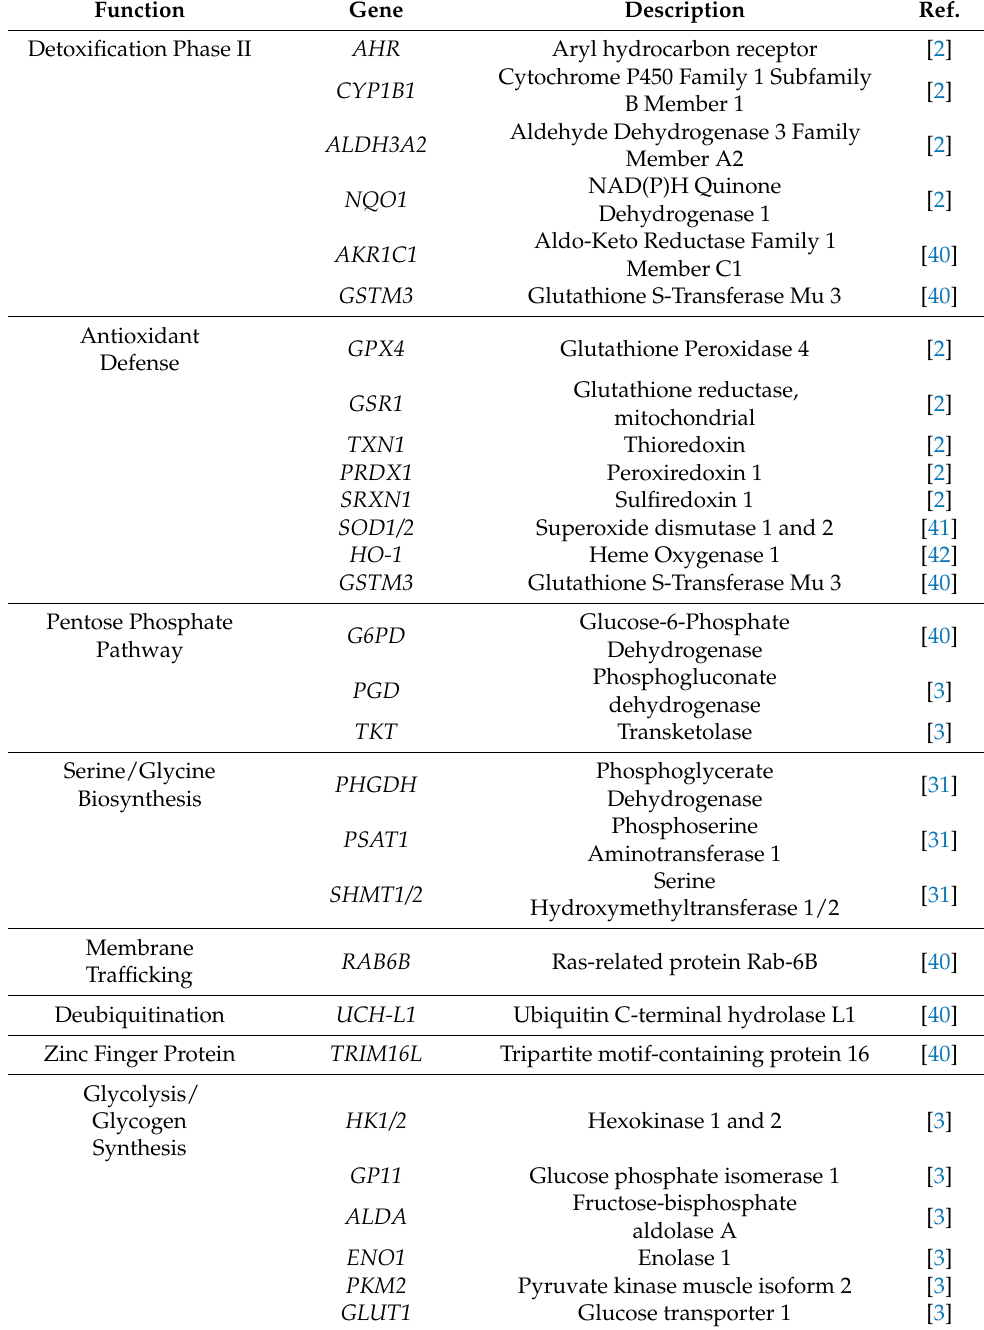
Table 3. Select Genes Controlled by Nrf2